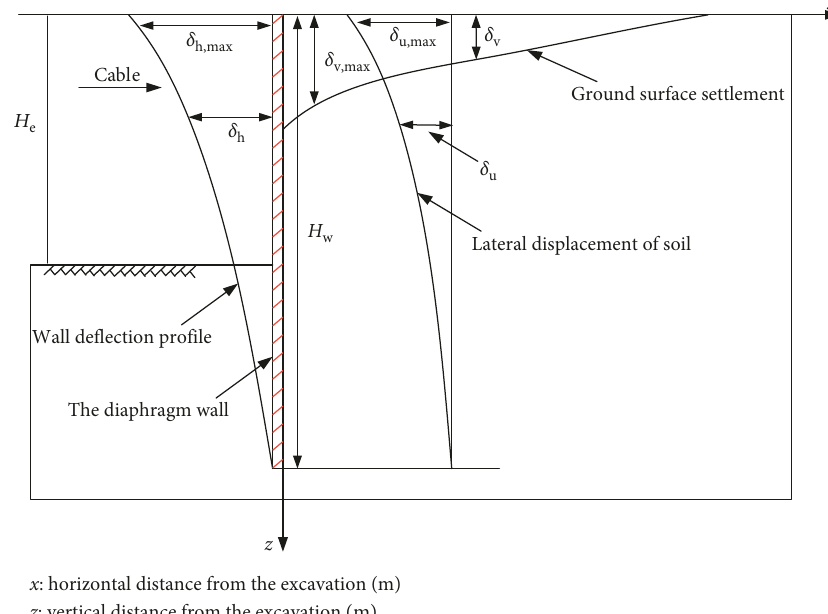
Figure 1: Sketch for the displacement of deep